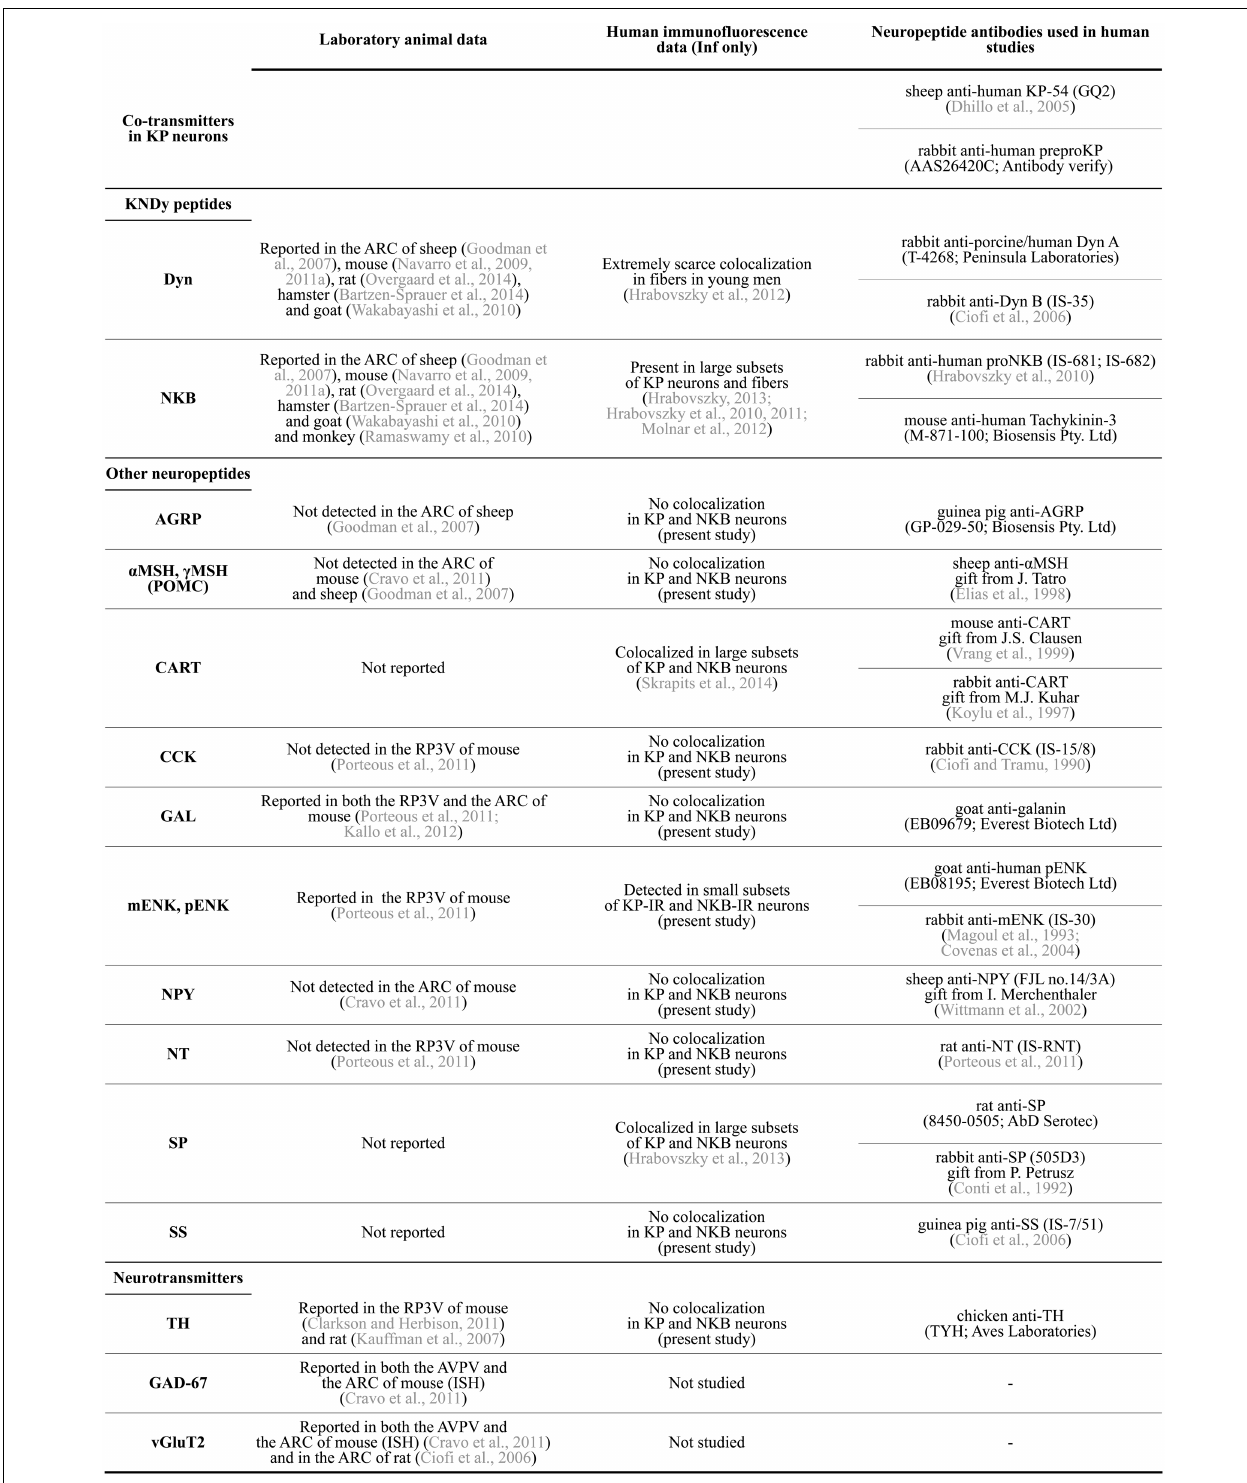
FIGURE 2 | Summary of neuropeptide/neurotransmitter co-expression data in KP neurons of laboratory animals and the human. AGRP, agouti-related protein; α MSH, α -melanocyte stimulating hormone; ARC, arcuate nucleus; AVPV, anterior periventricular nucleus; CART, cocaine- and amphetamine regulated transcript; CCK, cholecystokinin; Dyn, dynorphin; GAD-67, glutamic acid decarboxylase-67; GAL, galanin; Inf,